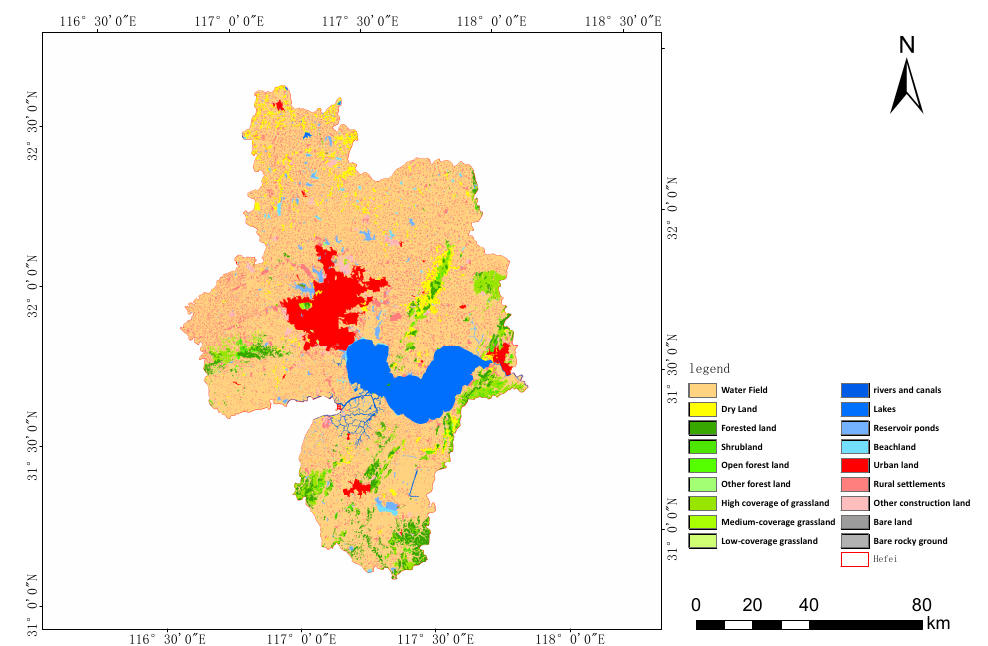
Figure 1. Distribution of utilization types in the Chaohu Lake